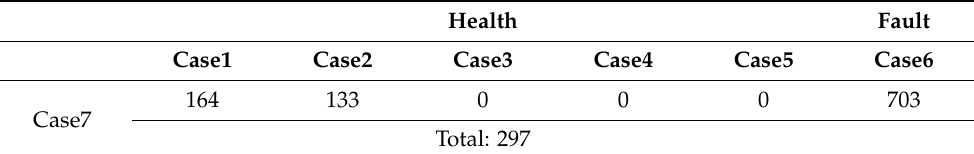
Table 6. The results of CNN for unlabeled data. Health